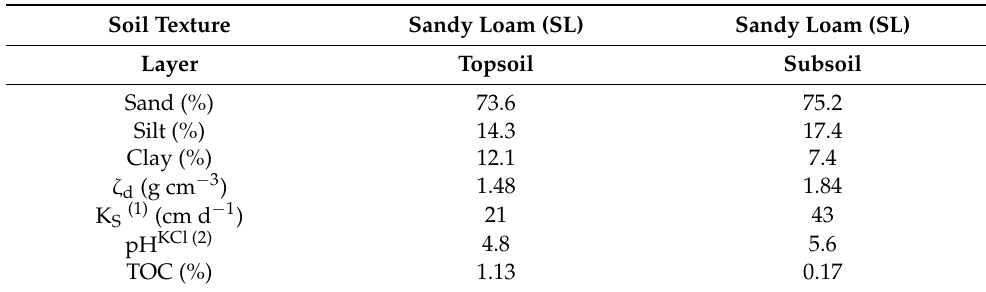
Table 1. Basic parameters of the lysimeter soils. Soil texture class (WRB, 2006), soil texture with